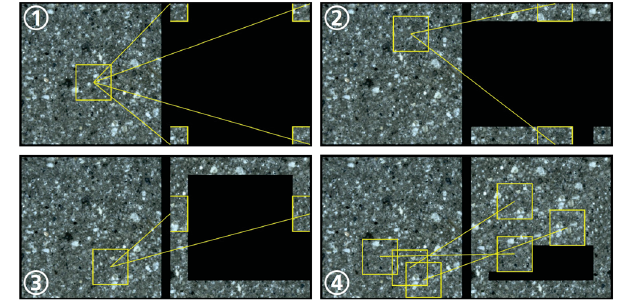
Fig. 3 Visualization of phases 1–4 of the algorithm. Left: source image. Right: synthesized texture.